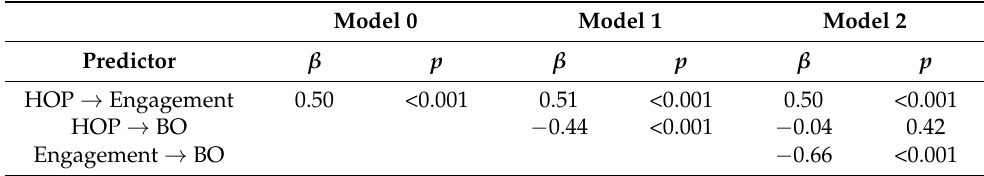
Table 3. Model path